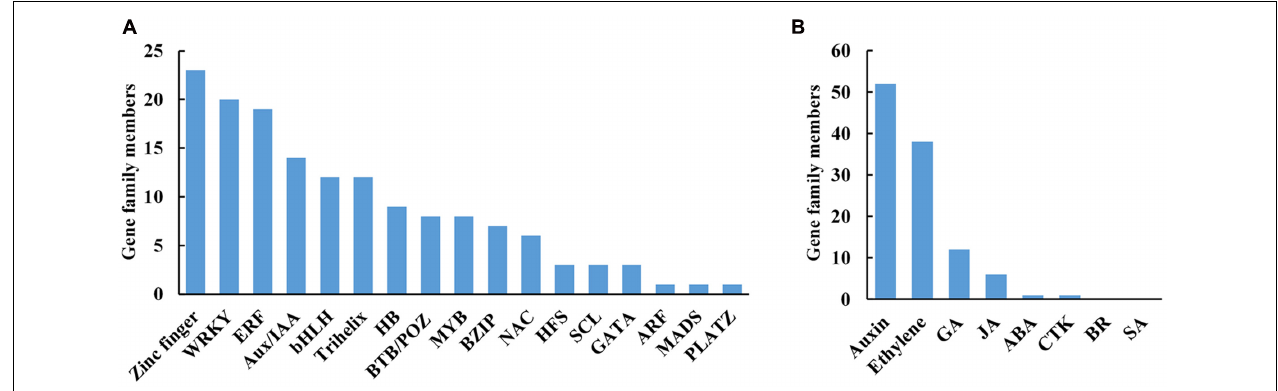
FIGURE 5 | Distribution of transcription factors (A) and hormone (B) related DTGs during petal abscission. DTGs were determined using a cutoff ratio of > 2 or < 0.5 when comparing its expression in stage 3 to that in stage 1 (S3 vs. S1), and/or in stage 5 to that in stage 3 (S5 vs. S3). GA, gibberellin; JA, jasmonate; ABA, abscisic acid; CTK, cytokinin; BR, brassinosteroid; SA, salicylic